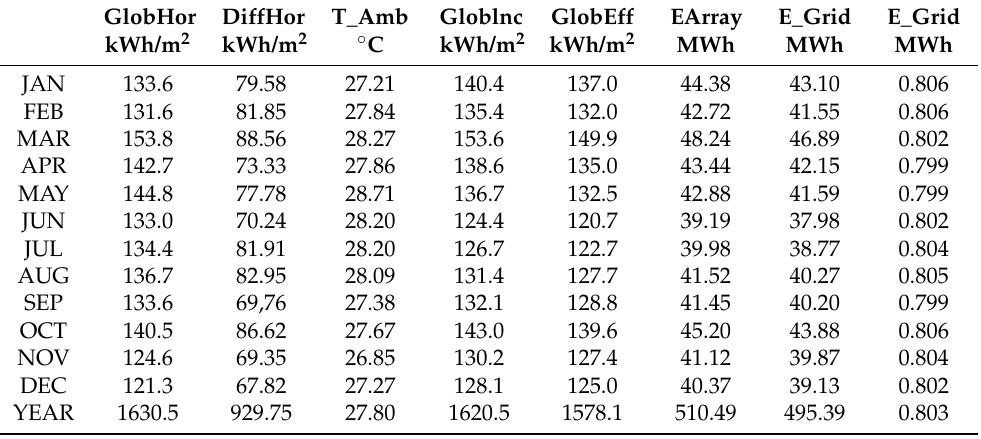
Table 7. Balance and main results.